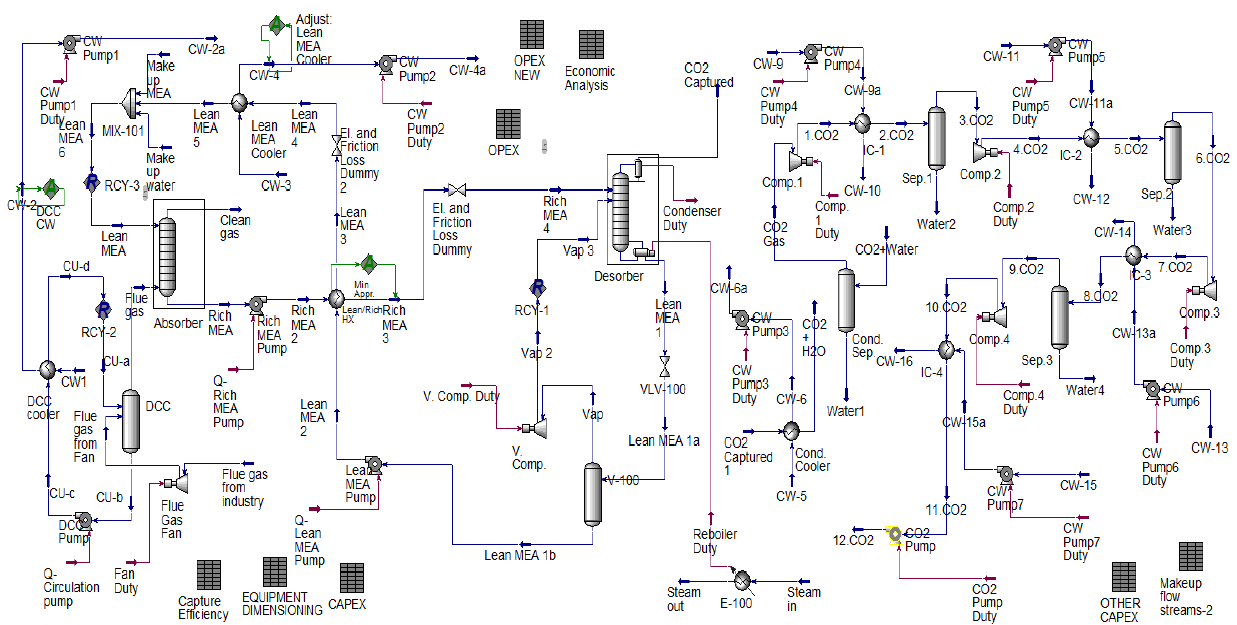
Figure A2. Aspen HYSYS simulations process flow diagram of the NGCC power plant LVC CO 2 capture process.